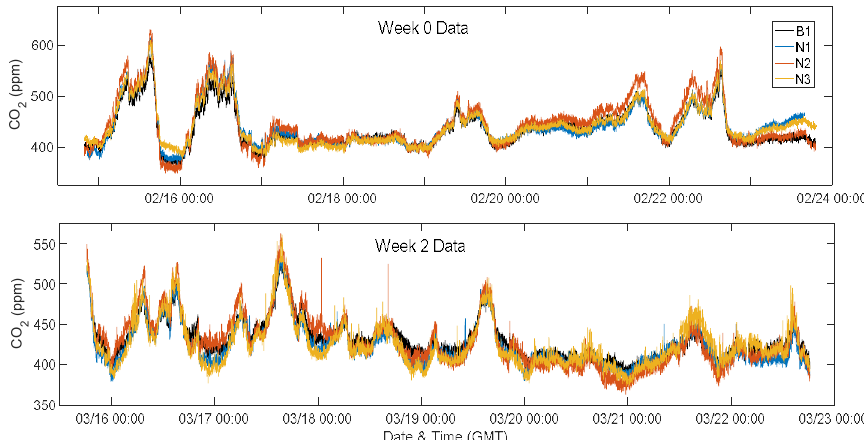
Figure A2. Time series of co-located ( top ) and deployed ( bottom ) Y-Pods, for examining neighborhood-scale variability of CO 2 .